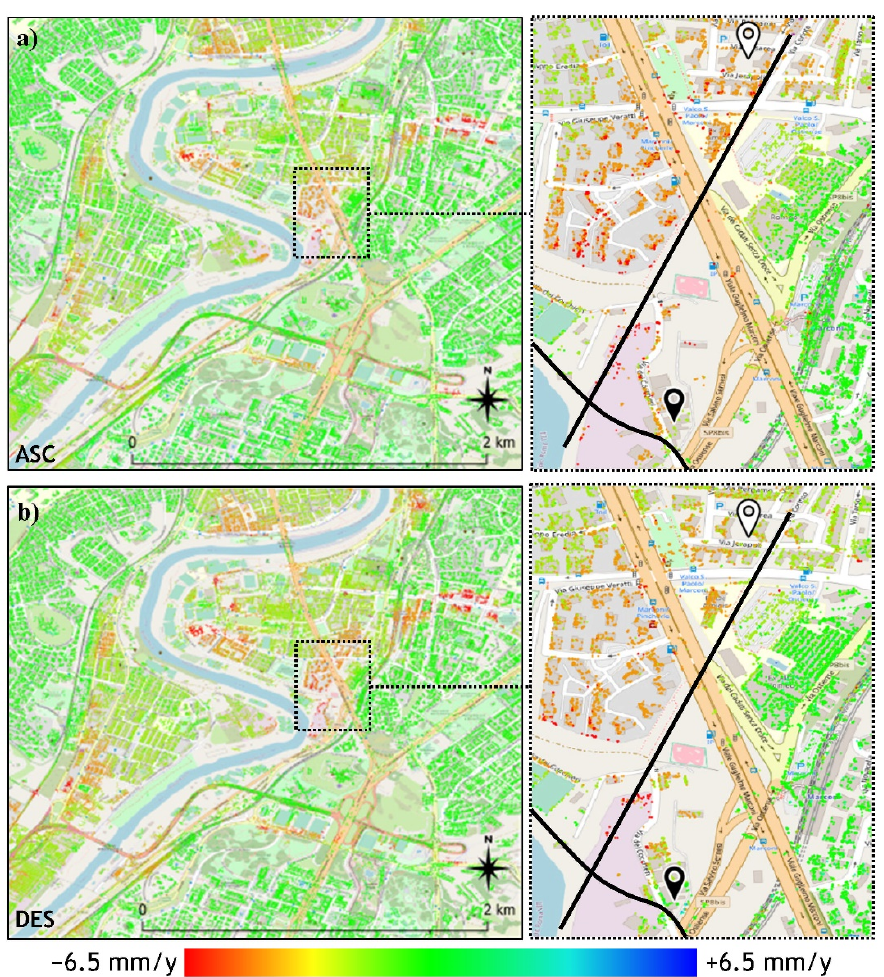
Figure 3. Mean deformation velocity maps: large view of the examined area, with a zoom on the Valco San Paolo area, for ( a ) ascending and ( b ) descending acquisition orbits (black and white benchmarks indicate the Collector sewer point of disposal n. 7 and the Torri Stellari complex, respectively; the continuous line indicates part of the Marana di Grotta Perfetta hydraulic management).